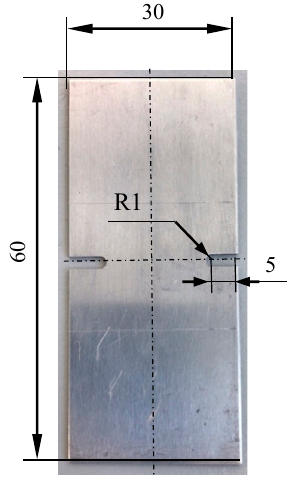
Figure 6. Geometry of specimen. J. Manuf. Mater. Process. 2020 , 4 , x FOR PEER REVIEW